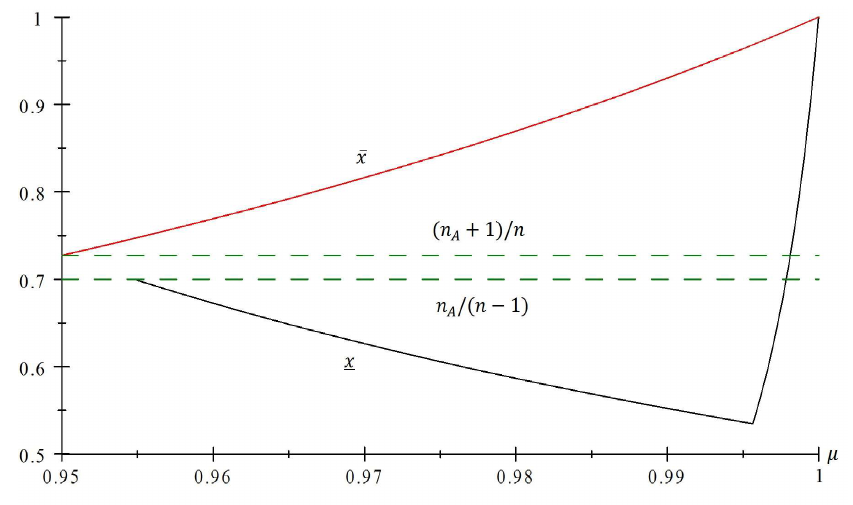
Figure 2. Set of no-delay SPE expected outcomes when n = 11, n B = 3 and δ =